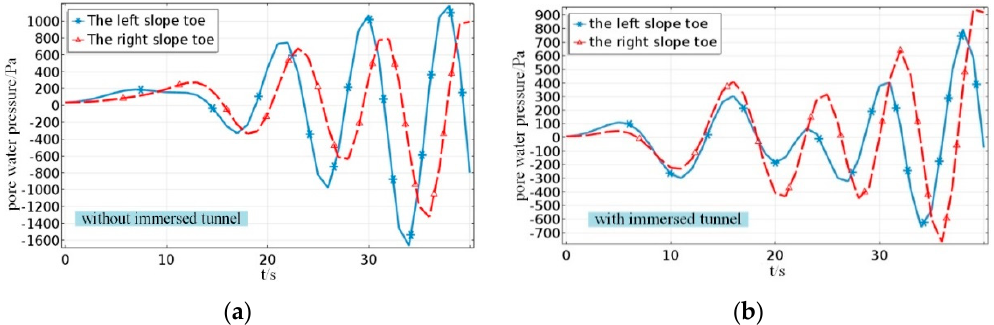
( b ) Figure 8. The pore pressure at two asymmetric points on the two-side slopes: ( a ) without immersed tunnel and ( b ) with immersed tunnel. Figure 9 shows the variation of the pore pressure at 1 m below the bottom two corners of the